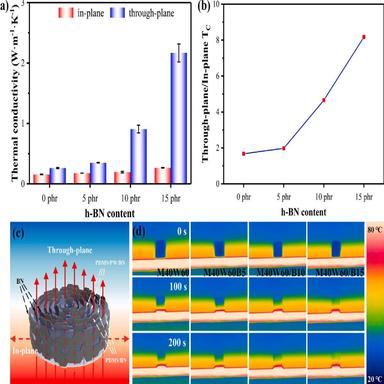
(a) The in-plane/through-plane thermal conductivity of M40W60Bx composites; (b) the through-plane/in-plane thermal conductivity ratio of M40W60Bx composites; (c) schematic diagram illustrating the heat conduction path of M40W60Bx composites; (d) The infrared images of M40W60Bx composites on an 80 ◦C hot stage shows the vertical heat transfer speed.